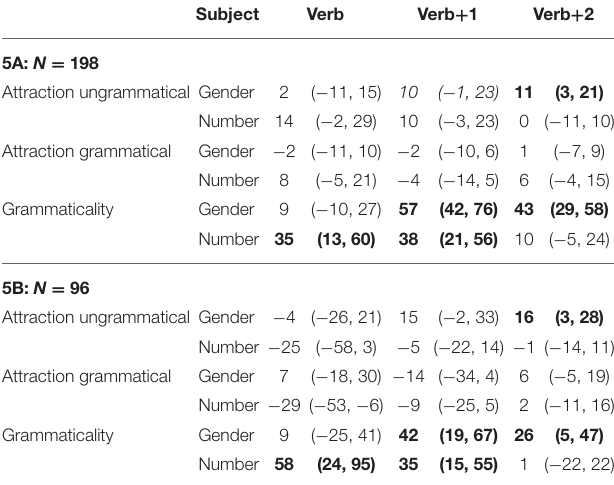
Table 9 | Results of experiment